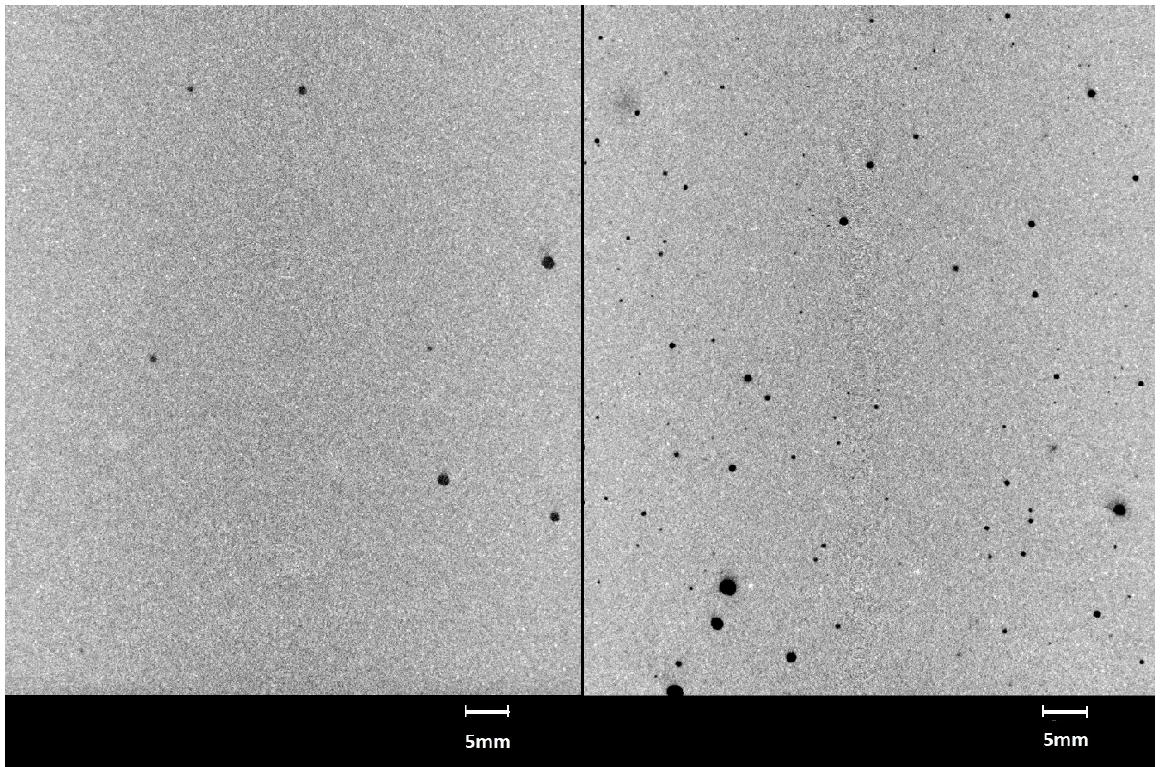
Figure 5. Porosity differences between the samples R3 (0:100, cement: slag left) and R4 (100:0, cement:slag right). Table 7. Porosities of all CPB samples measured in X-ray computed tomography (XCT) images. CPB Specimens (Cement:Slag Ratio)